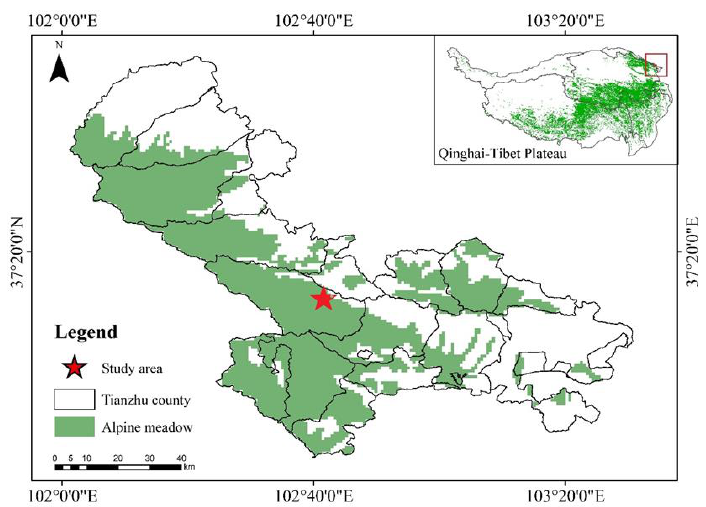
Figure 1. Location of the research site in Tianzhu Tibetan Autonomous County on the northeastern edge of the Qinghai – Tibet